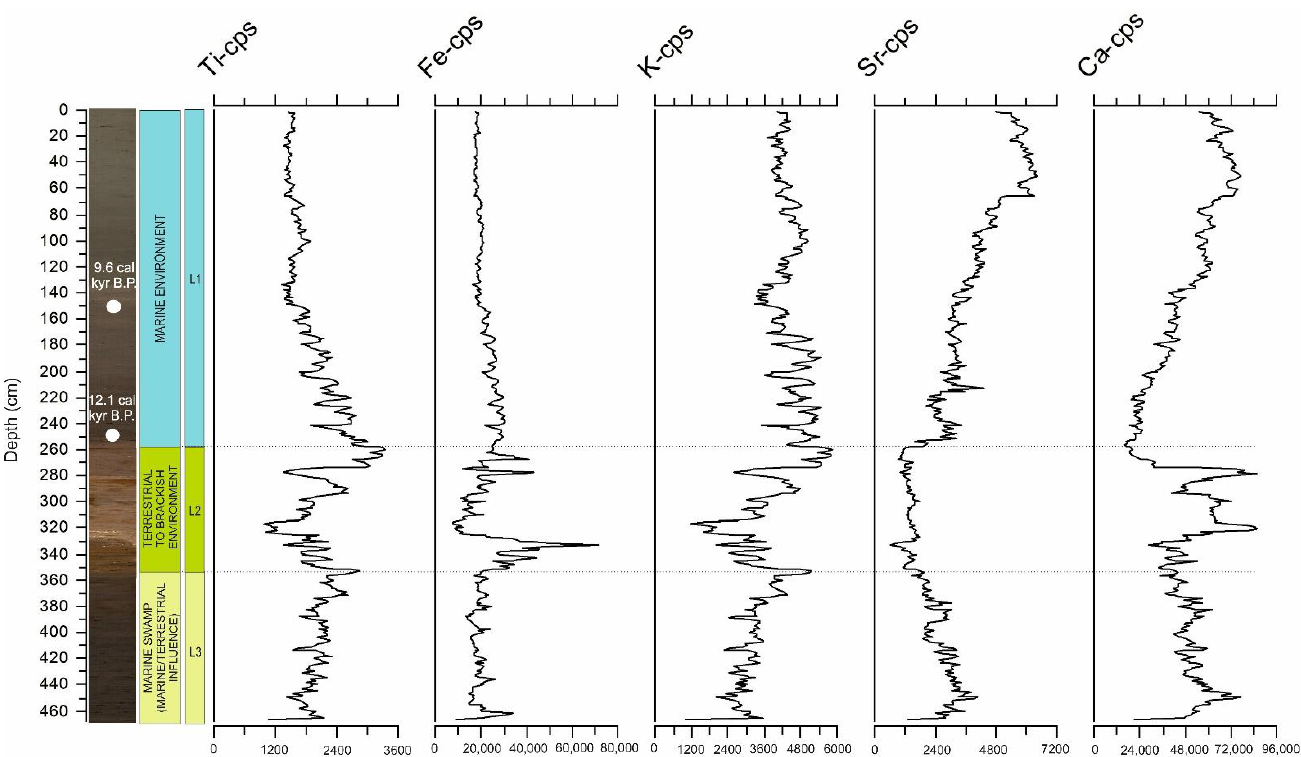
Figure 9. Sediment core KK-1 and lithological units with variability of MS and elemental ratios obtained using the XFR core scanner. The core penetrates unit S.S.S.1–unit U1a (lithological unit L1) and unit S.S.S.2–unit 2a (lithological units L2 and L3). The hiatus is the erosional surface between units S.S.S.1 and S.S.S.2. On the Zr/Ti graph, the peak in the black circle represents the sample with a high Zr/Ti ratio younger than the 9.6 cal kyr BP, containing glass shards that could belong to one of the Vesuvius Plinian eruptions of Mercato, with a modelled age of 8.59–0.23 cal kyr BP present in Veliko Jezero on the nearby Mljet Island [23].